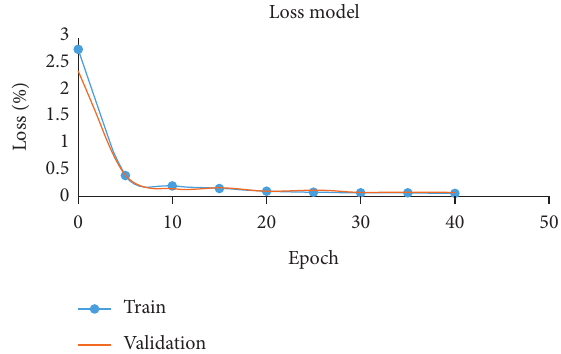
Figure 21: Result of loss function while training VGG-16.